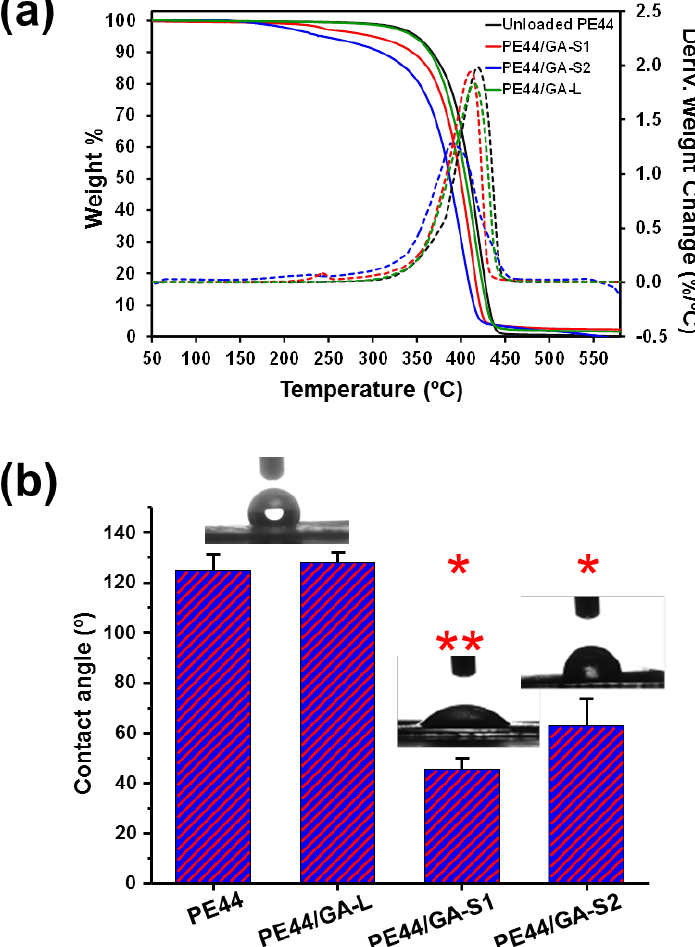
Figure 7. For unloaded PE44, PE44/GA-S1, PE44/GA-S2 and PE44/GA-L electrospun fibers: ( a ) TGA (solid lines) and DTGA (dashed lines) curves; and ( b ) contact angle. * Significantly different with respect to unloaded PE44 and PE44/GA-L with p < 0.05. ** Significantly different with respect to PE44/GA-S2 with p < 0.05.